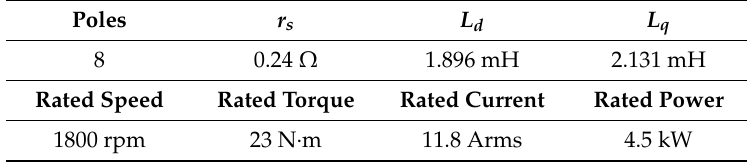
Table 2. Parameters of the PMSG.